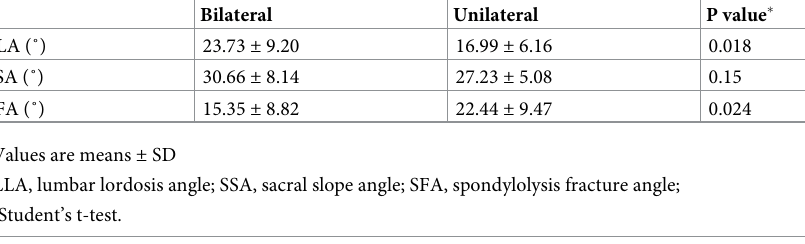
PLOS ONE | https://doi.org/10.1371/journal.pone.0276337 October 18,